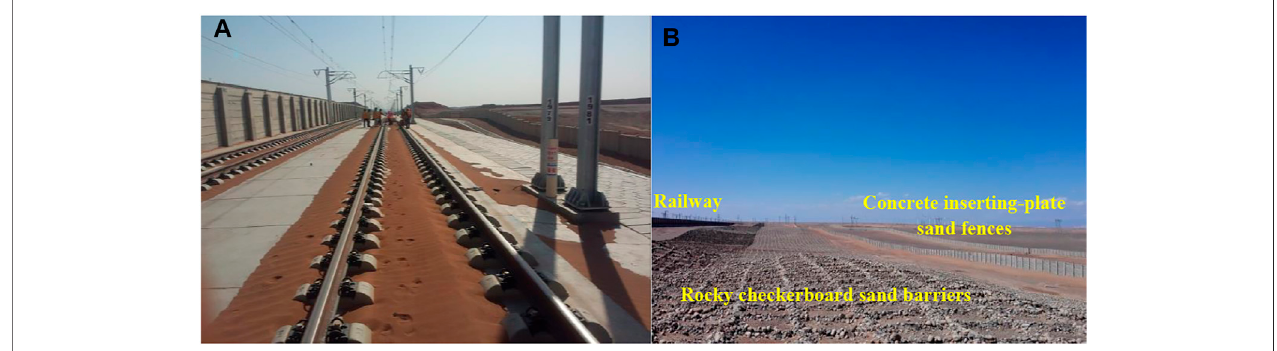
FIGURE 1 | (A) Sand deposition around the rail bed; (B) blown-sand control system built on the windward side of the railway (Wang et al.,